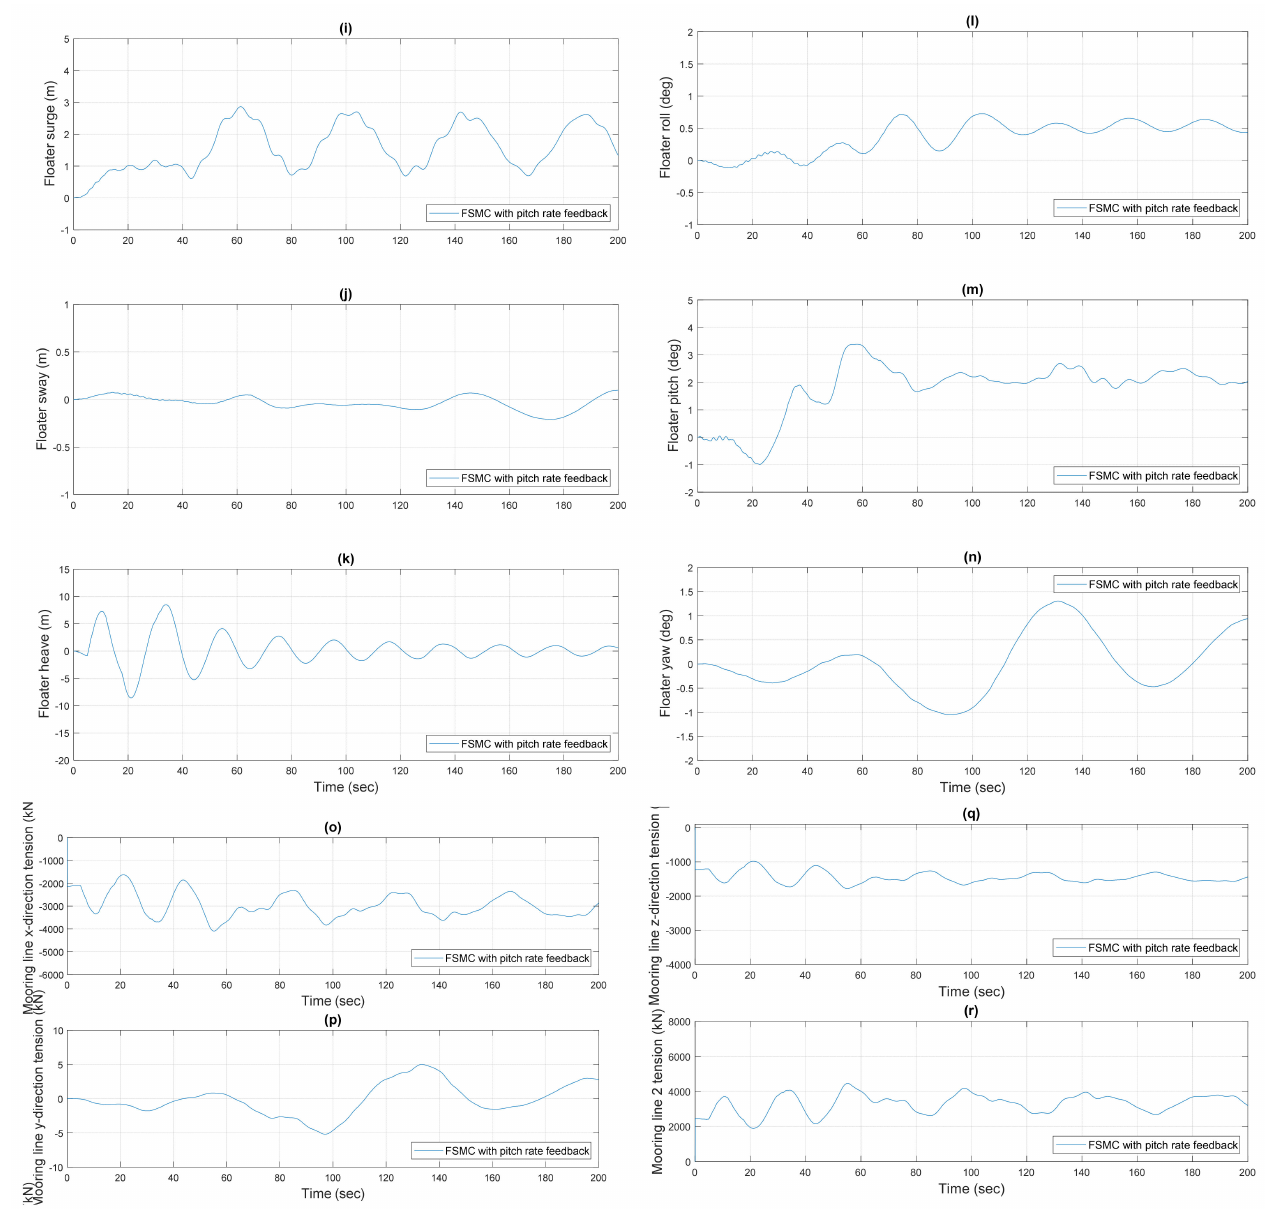
Figure 14. Simulation results of floating wind turbine by FSMC, with pitch-rate feedback in normal conditions; wind speed from 3 m/s to 16 m/s with 3% turbulence intensity, wave height of 1.4 m, and wave period of 7.8 s: ( a ) wind speed, ( b ) wave height, ( c ) rotor speed, ( d ) rotor-speed error, ( e ) output power, ( f ) generator torque, ( g ) blade-pitch, ( h ) tip-speed ratio, ( i ) floater surge, ( j ) floater sway, ( k ) floater heave, ( l ) floater roll, ( m ) floater pitch, ( n ) floater yaw, ( o ) mooring-line x-direction tension, ( p ) mooring-line y-direction tension, ( q ) mooring-line z-direction tension, ( r ) mooring-line